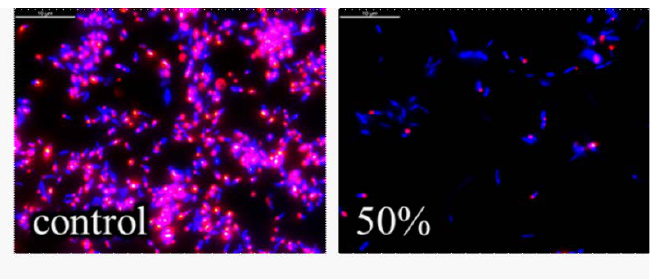
Figure 7. Fluorescence images of E. coli after 1 h incubation with peptide fraction with MW below 10 kDa (red—live cells; blue—dead cells). The marker corresponds to 10 µm.